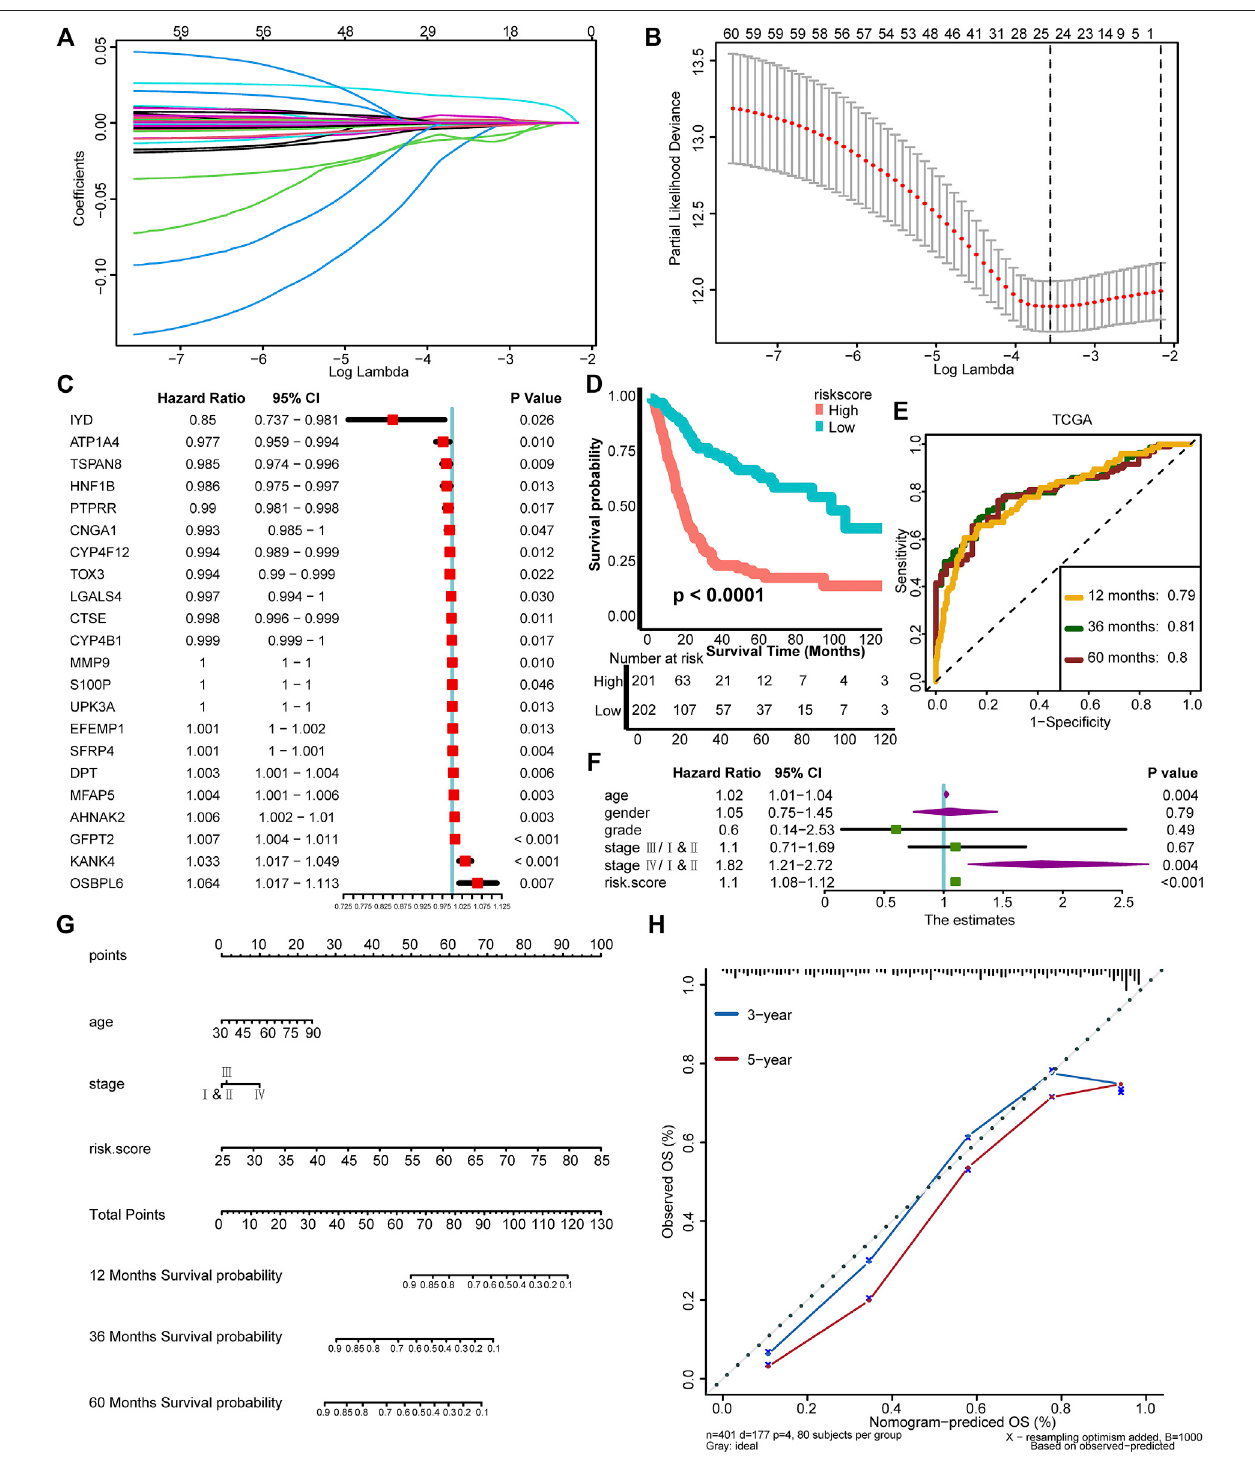
FIGURE 2 | Development of a TNF family – based risk score in the TCGA-BLCA cohort. (A) Coef fi cients of TNF-related DEGs with prognostic value are shown by lambdaparameter. (B) Partiallikelihooddevianceversuslog(lambda)drawnbyLASSOalgorithmand cross-validation. (C) Theunivariate analysisof22TNF-associated genes selected for developing risk score is shown in forest plots. (D) K-M plot of OS between TNF-based risk score groups; red and azure lines represent high and low TNF-basedriskscoregroups,respectively. (E) Theareaunderthecurve(AUC)plotofTNF-basedriskscoreinTCGAtrainingcohort. (F) Forestplotsofmultivariate Cox analysis of TNF-based risk score combined with age, gender, tumor grade, and stage of BLCA. (G) Nomogram developed by using age, tumor stage, and TNF- based risk score. (H) Calibration curves of the nomogram.